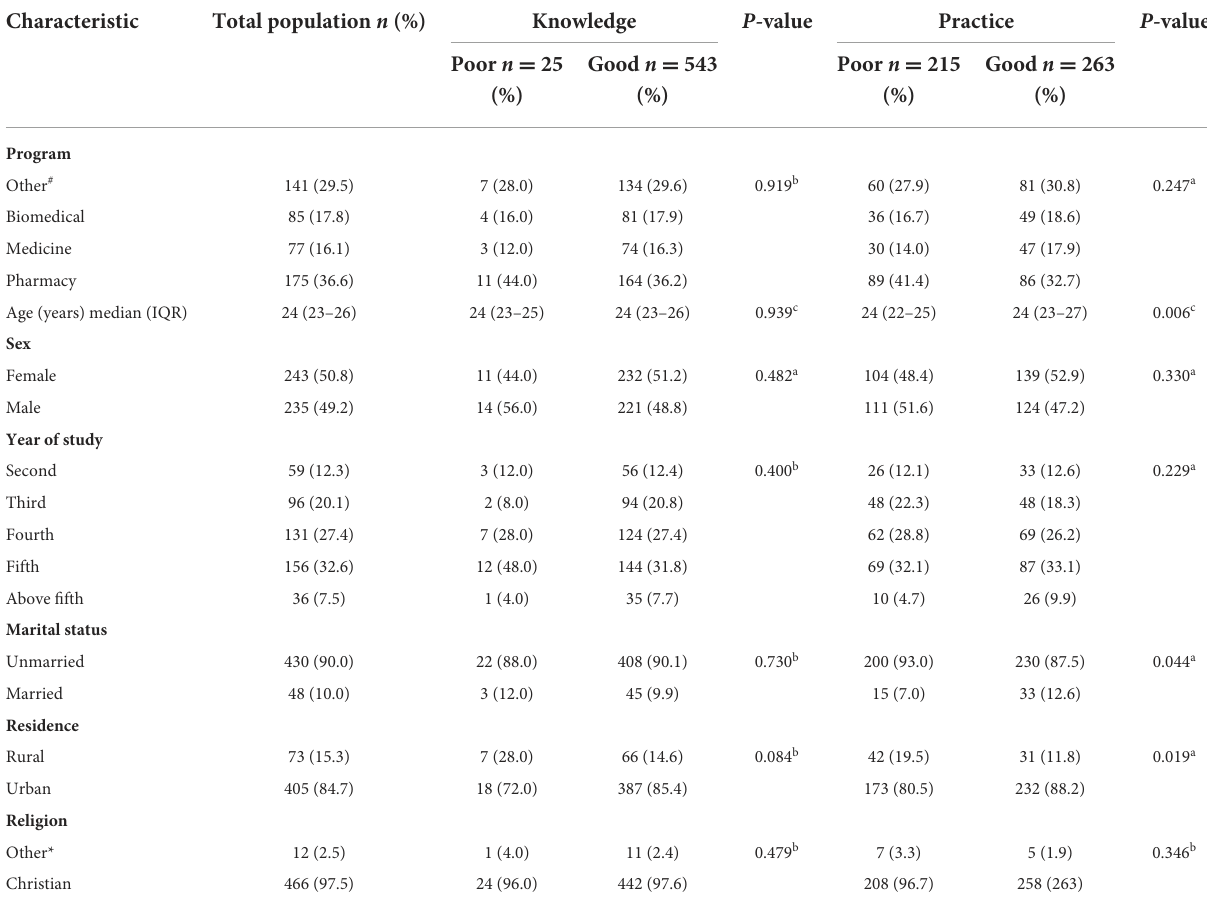
TABLE 1 Socio-demographic characteristics of study participants, N =